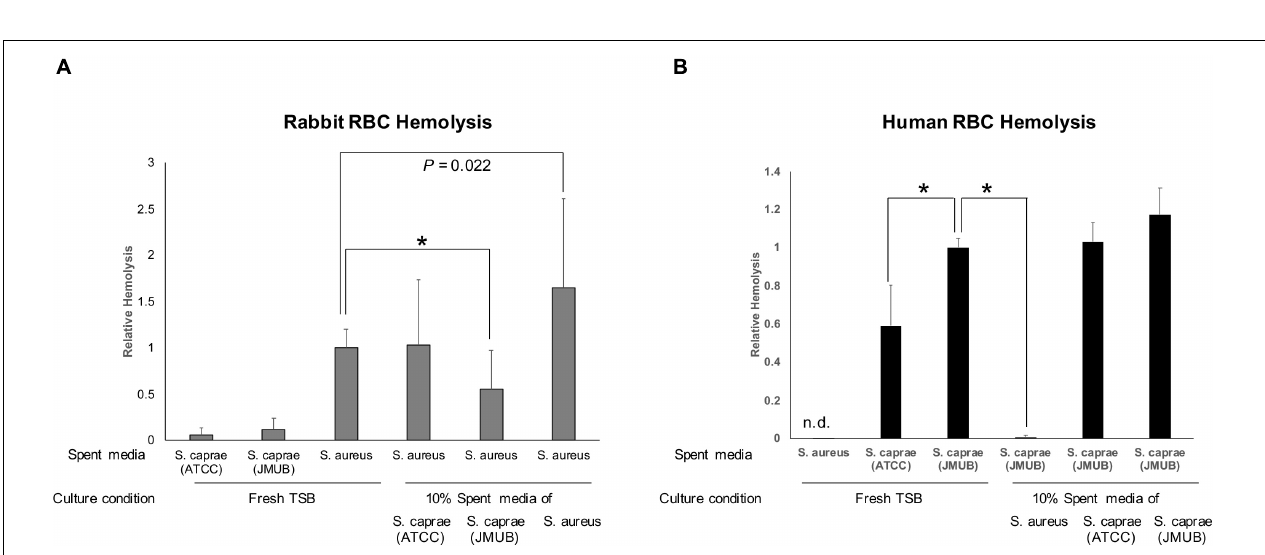
FIGURE 7 | Hemolysis by spent medium. Autoinducer peptides are indicated by underlines. (A) Lysis of rabbit blood cells. Fresh or spent medium of S. aureus N315, S. caprae ATCC 35538, or S. caprae JMUB145 was added to the final 10%, followed by incubation of S. aureus N315 overnight. S. caprae ATCC 35538 and S. caprae JMUB145 were incubated in fresh medium. Spent media were utilized for the assay. (B) Human blood cells. Fresh or spent medium of S. aureus N315, S. caprae ATCC 35538, or S. caprae JMUB145 was added to the final 10%, followed by incubation of S. caprae JMUB145 overnight. S. aureus N315 and S. caprae ATCC 35538 were cultured in fresh medium. P -values were calculated by Student’s t -test. An asterisk indicates p < 0.001.